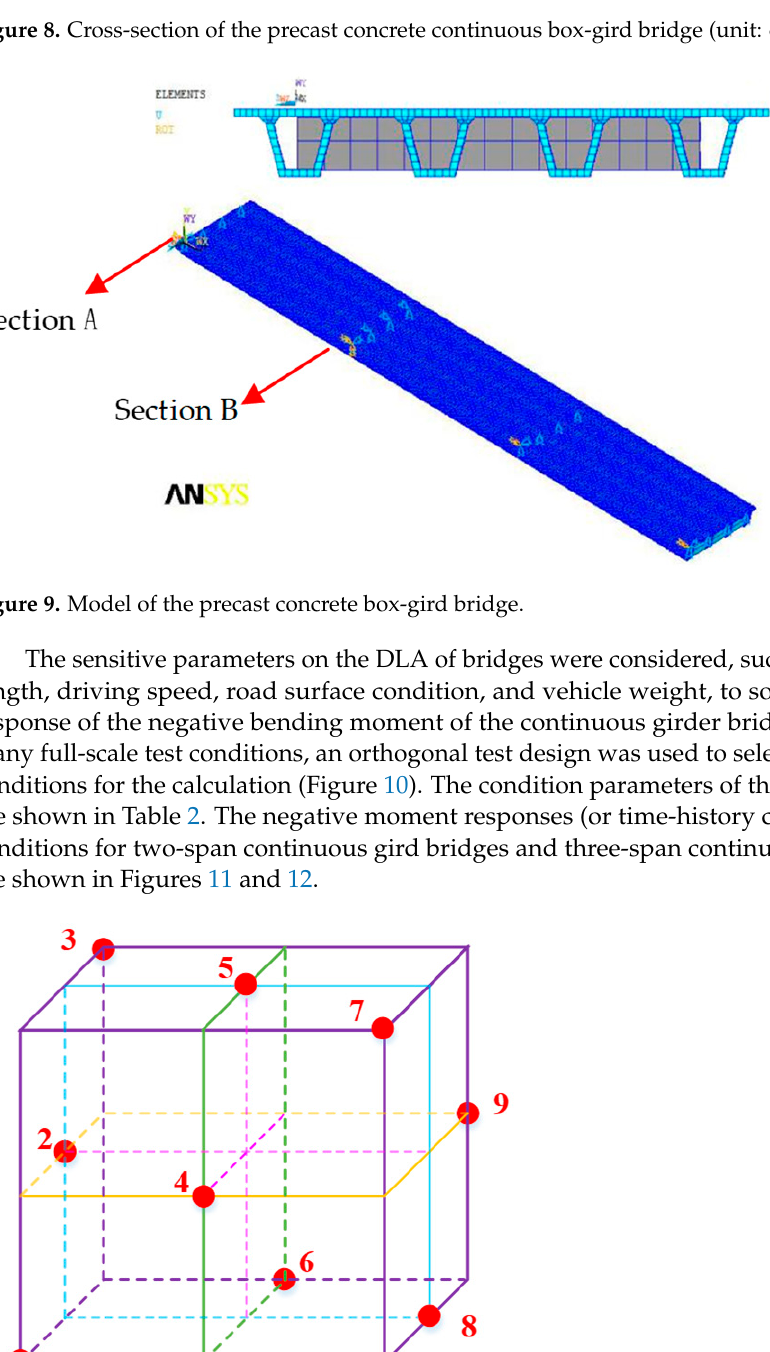
Figure 8. Cross-section of the precast concrete continuous box-gird bridge (unit: cm).